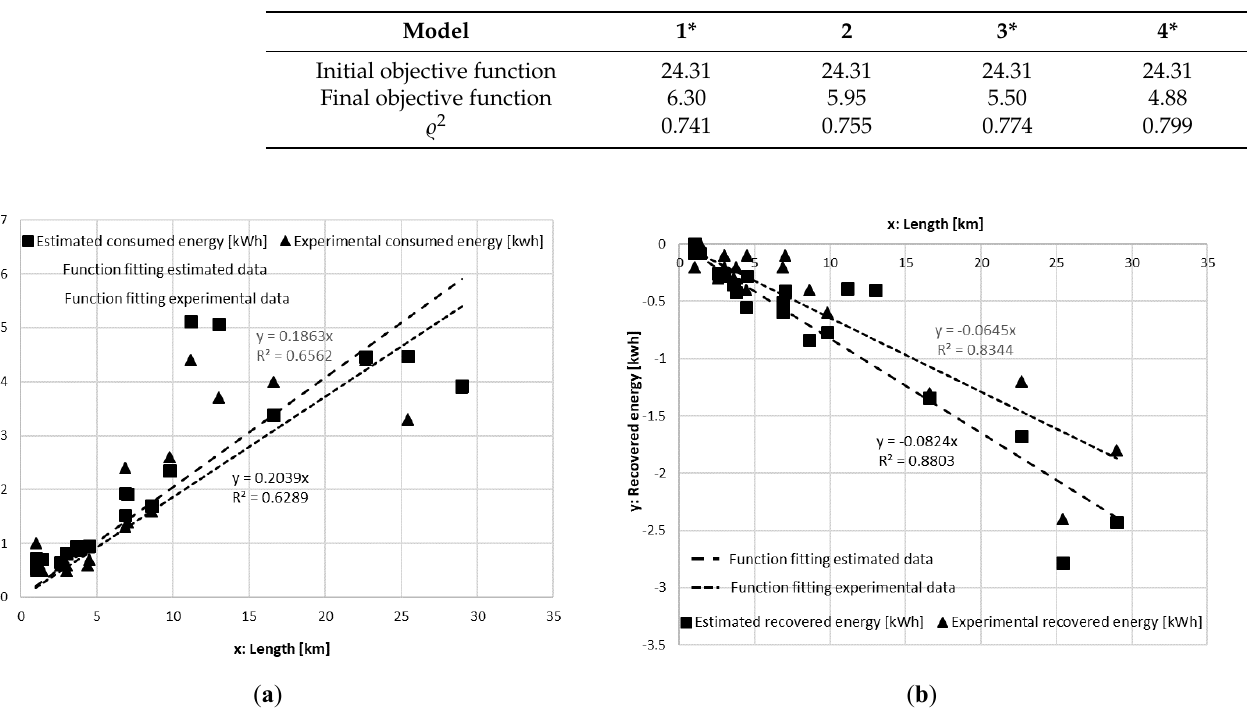
Table 5. Validation statistics.